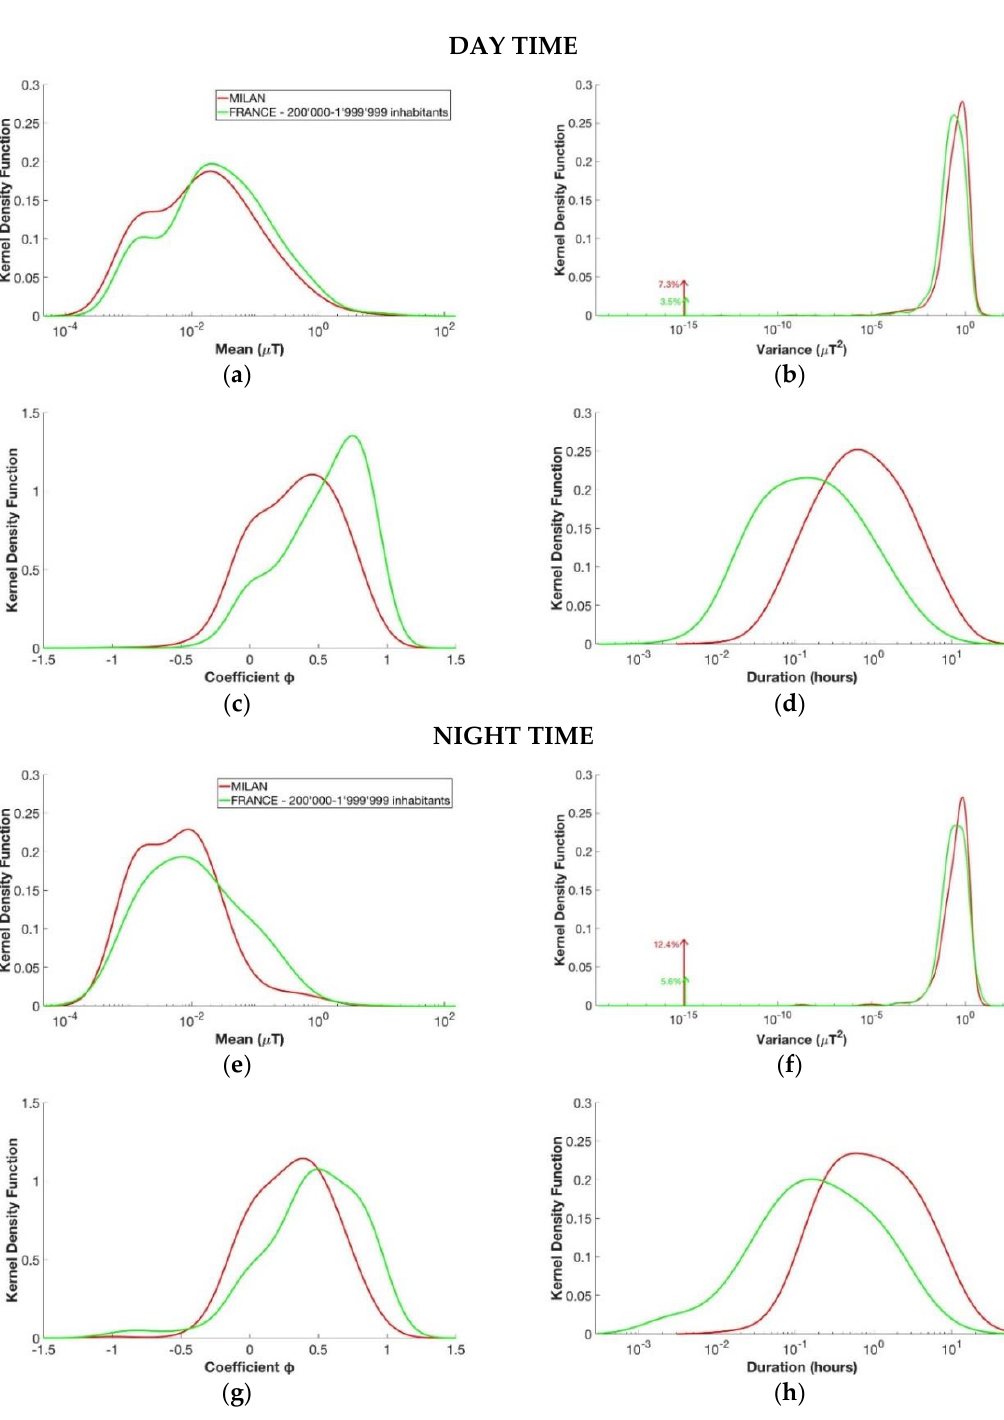
Figure 6. Estimated kernel density function for the four variables of the segments of the day in the upper part and for the segments of the night in the lower part. From above to down, left to right: ( a, e ) mean µ, ( b, f ) variance σ 2 , ( c, g ) coefficient φ, and ( d, h ) duration T. The groups considered are those with registration of Milan from the ARIMMORA database (in red) and the group of 200,000–1,999,999 inhabitants from the EXPERS database (in green).